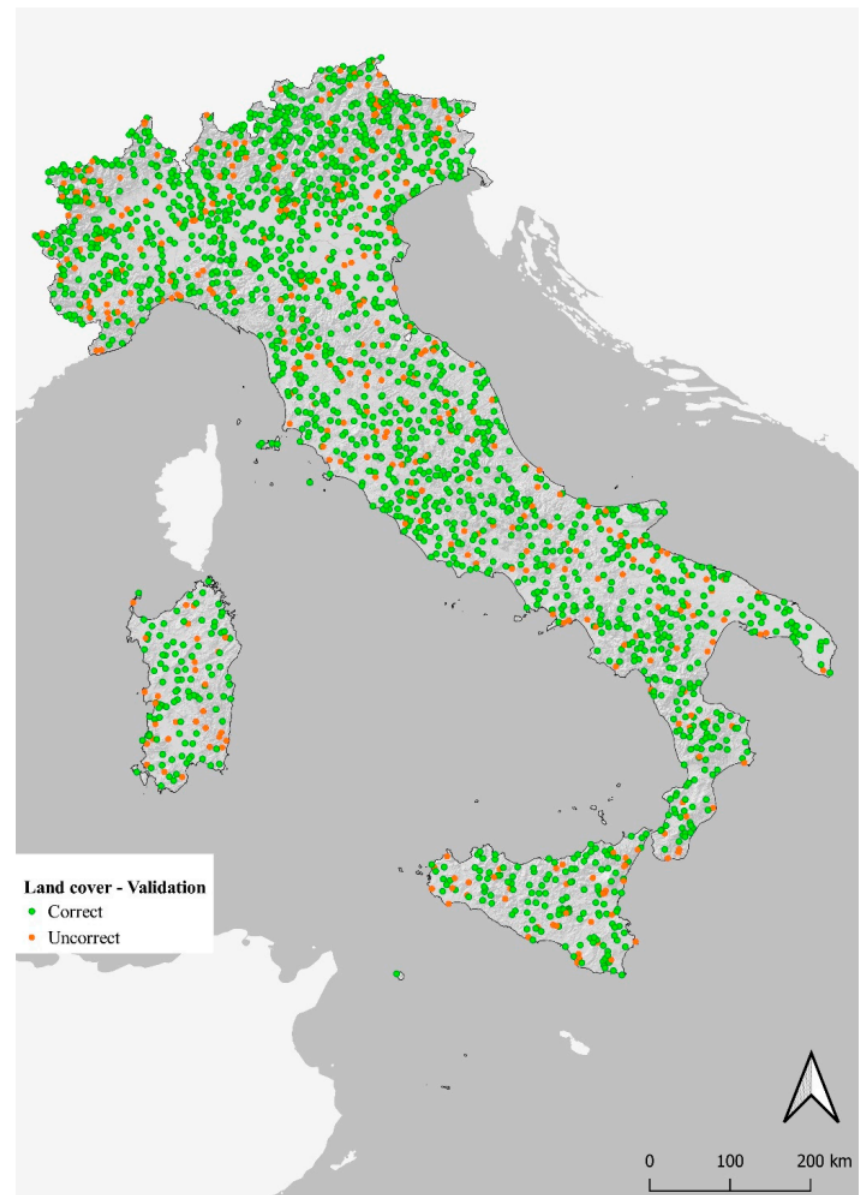
Figure 4. Result of the accuracy assessment with reference to the sample of 2400 photo-interpreted